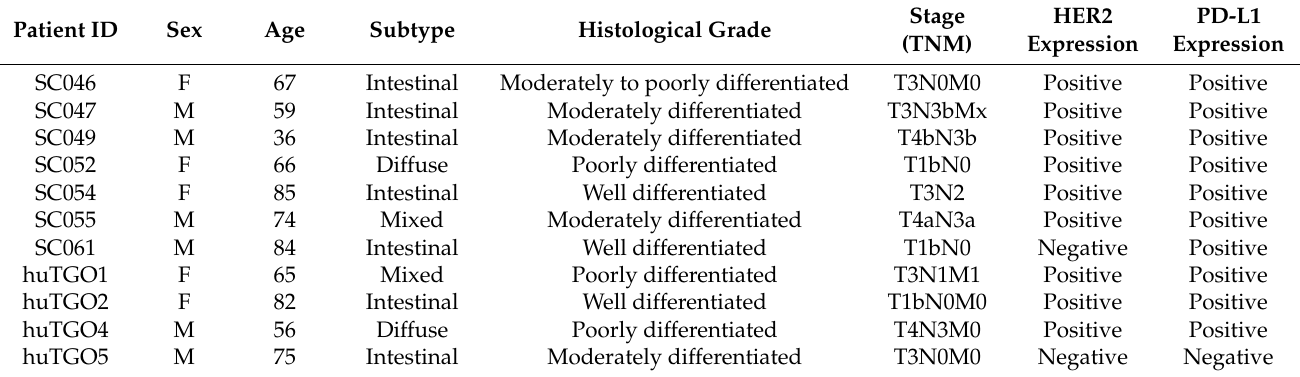
Table 1. Demographics and Pathological Profiles of Gastric Cancer